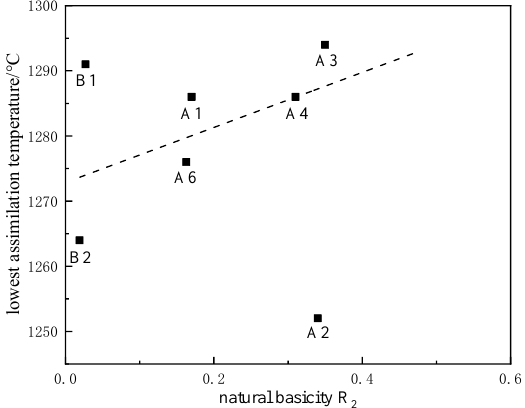
Figure 9. Influence of natural basicity R 2 on assimilation temperature.